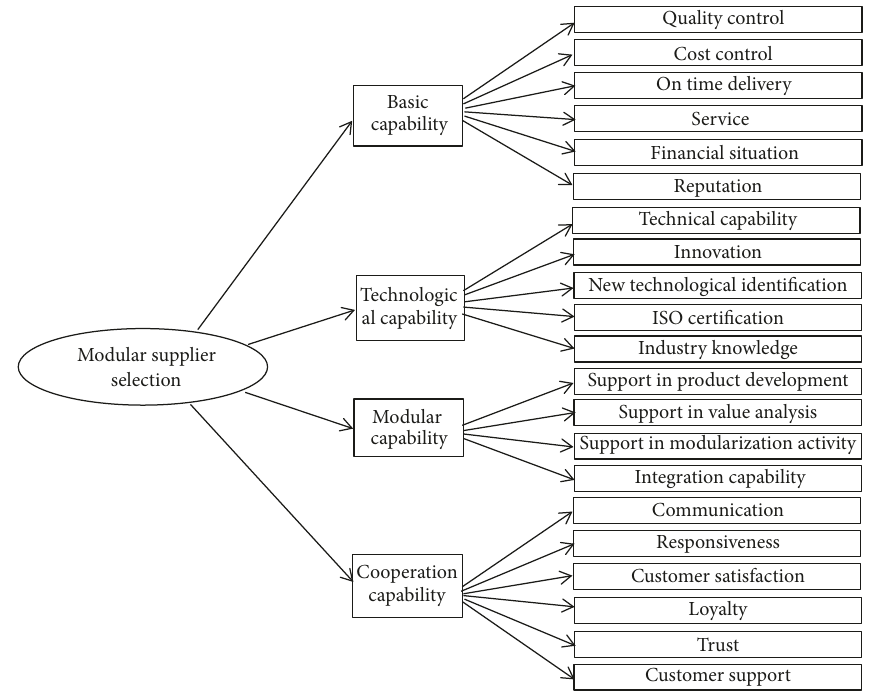
Figure 1: Conceptual